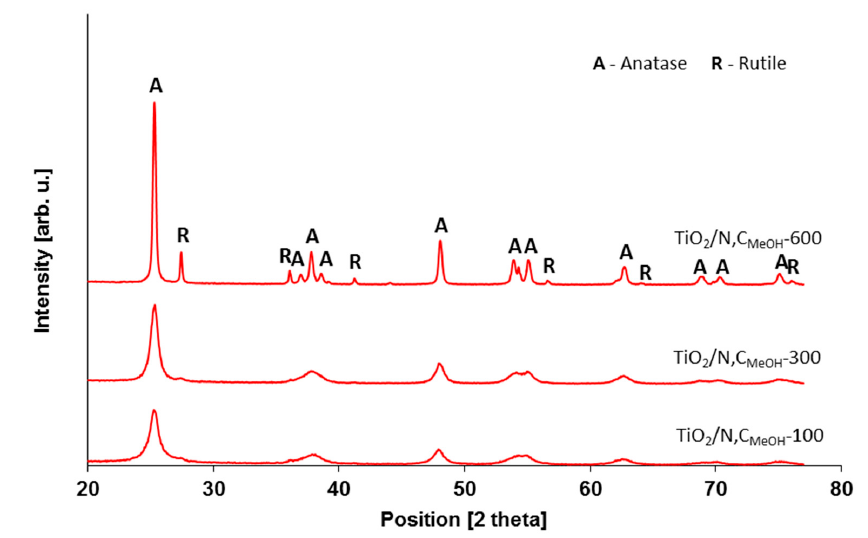
Molecules 2019 , 24 , x Figure 1. XRD patterns of photocatalysts modified with e.g., methanol at di ff erent temperatures. Figure 1. XRD patterns of photocatalysts modified with e.g., methanol at different temperatures.